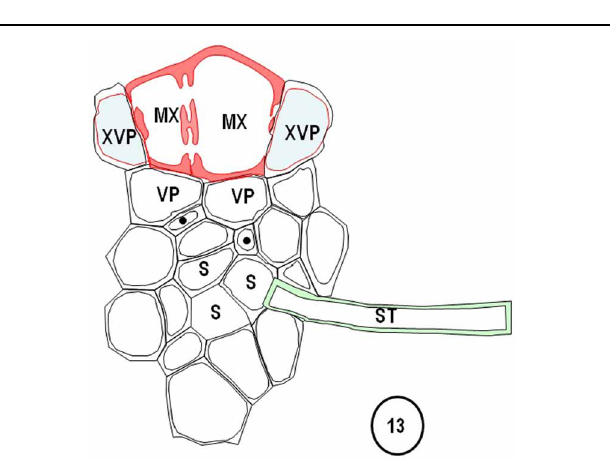
FIGURE 13 | Diagrams redrawn and interpreted from Figure 11, showing a thin-walled sieve tube (S) connection to a transverse vein ST. The emergences of a transverse vein ST from its longitudinal vein connection. XVPs (with half-bordered pit-pairs) about the xylem (MX) and vascular parenchyma (VP) are in association with the TSTs.